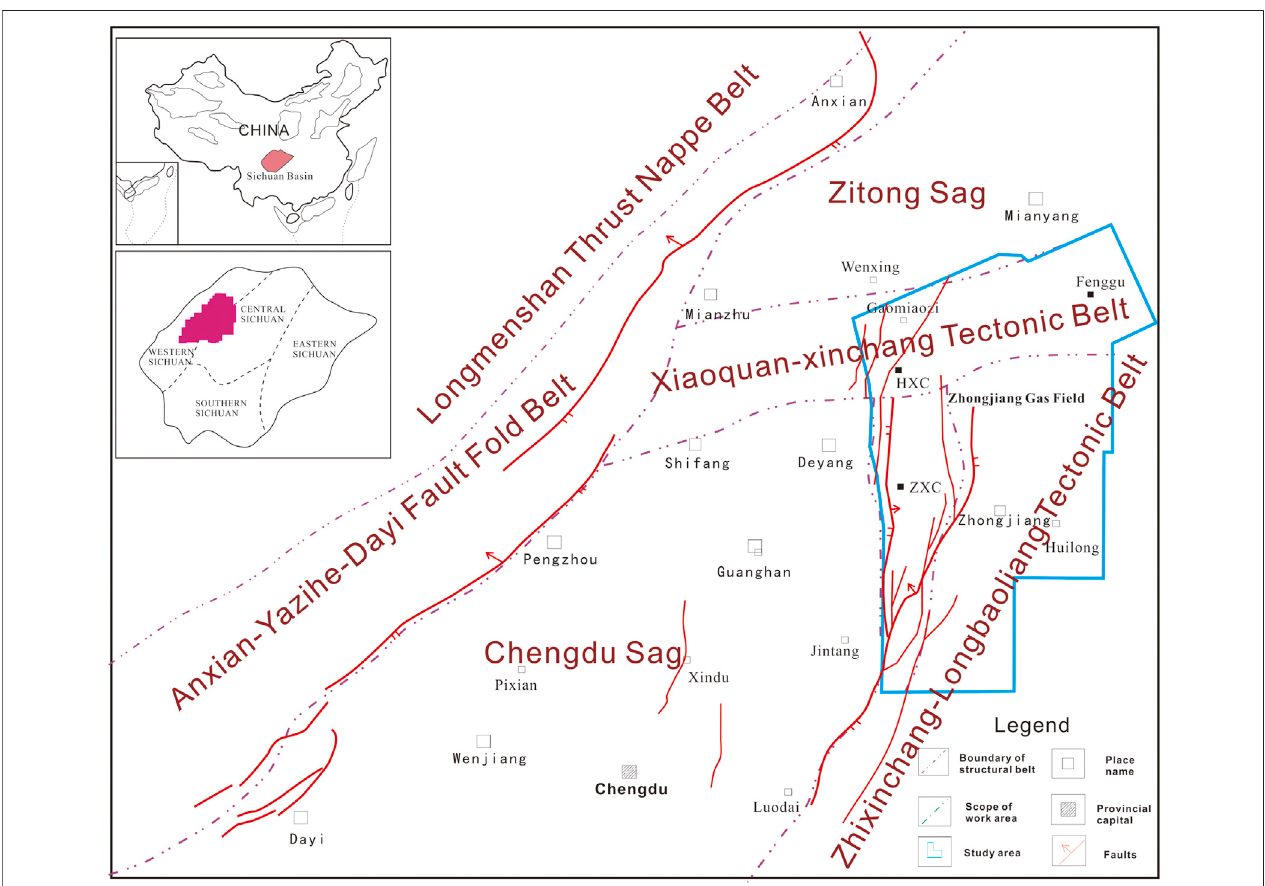
FIGURE 1 | Location of the Sichuan Basin and research area in the western Sichuan depression.